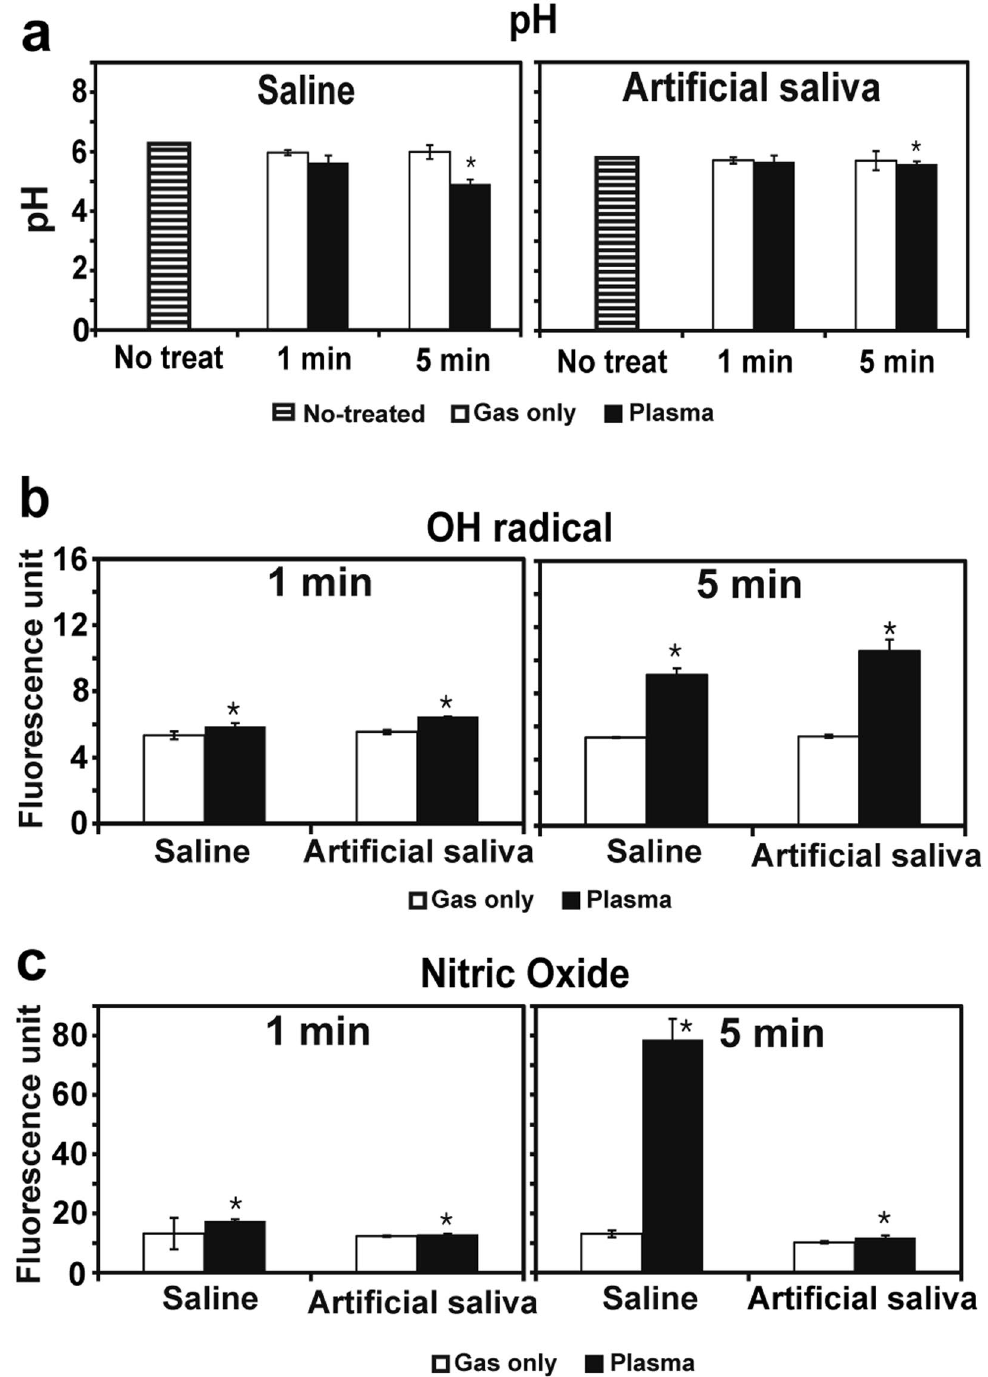
Figure 4. Changes in pH, OH radical level, and NO level in saline or artificial saliva after plasma treatment for 1 min or 5 min. ( a ) pH of saline and artificial saliva after gas or plasma treatment. ( b ) OH radical level in saline and artificial saliva after gas or plasma treatment. ( c ) Levels of NO species in saline and artificial saliva after gas or plasma treatment. Levels of OH radical and NO are indicated by fluorescence intensity of terephthalic acid (TA) and 4-Amino-5-Methylamino-2 ′ ,7 ′ -Difluorofluorescein combined with OH radical and NO, respectively. All values are means ± standard deviations of nine measurements. * P <